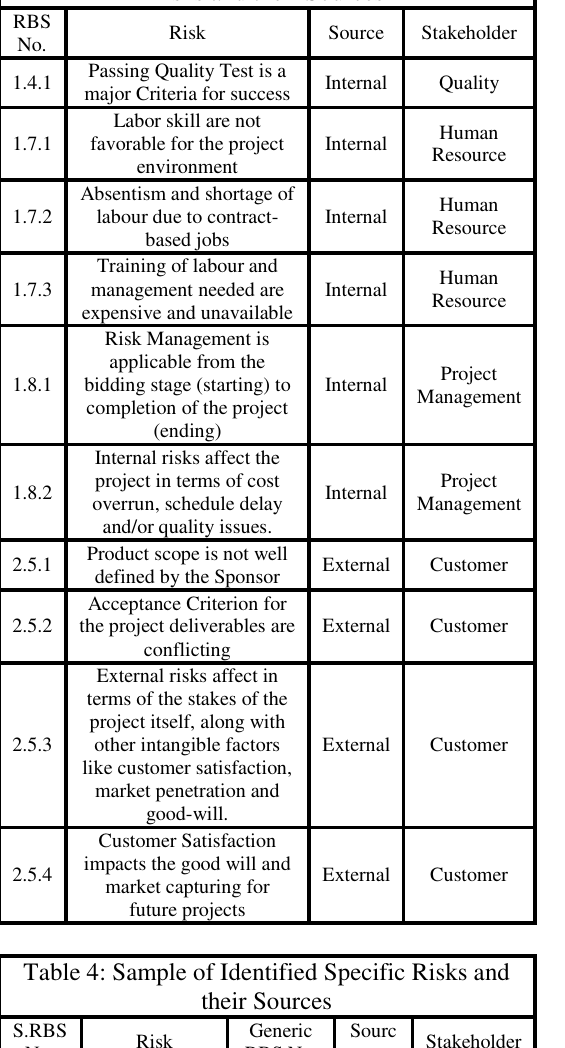
Table 3: Sample of Identified Major and Generic